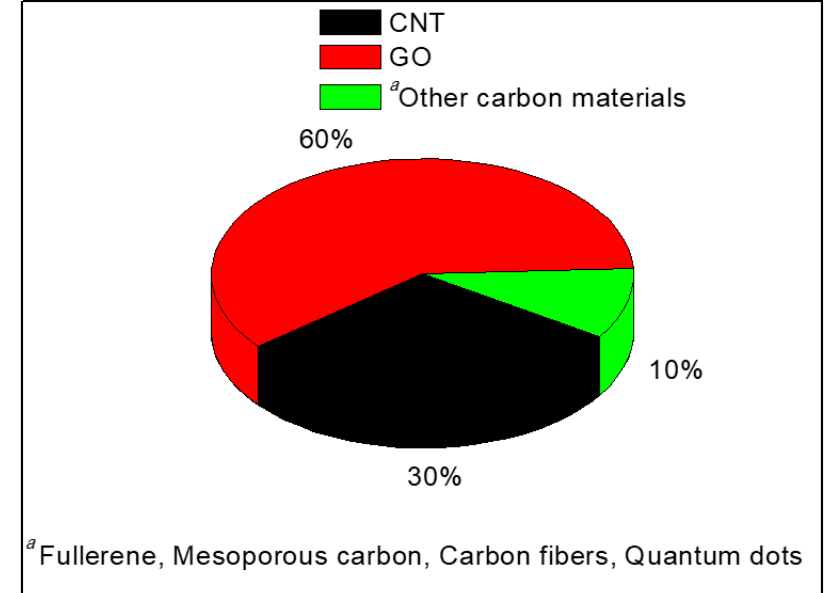
Figure 5. Percentage of GO, CNT and other carbon-based membrane electrolytes reported during last ten years. The data is generated by considering the references listed in Table 1.